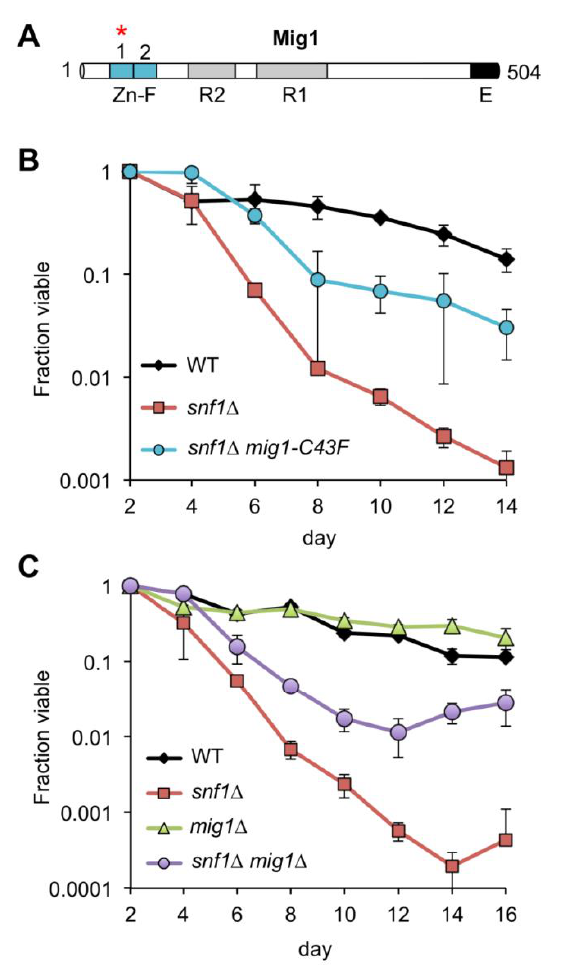
FIGURE 3: Mutations in MIG1 partially restore CLS to a snf1 ∆ strain. (A) Diagram of Mig1 protein domain organization showing the two zinc fingers (Zn-F), two regulatory domains (R1 and R2) and an effector domain (E) [36]. Red asterisk indicates the zinc finger mutated (C43F) in suppressor candidate JS1430. (B) Quanti- tative CLS assay showing short CLS of snf1 ∆ (JS1394) compared to WT (JS1256). The snf1 ∆ mig1-C43F mutant (JS1430) extends CLS compared to snf1 ∆. (C) Quantitative CLS assay showing similar partial CLS extension by deleting MIG1 in the snf1 ∆ background (JS1446). Deletion of MIG1 had little CLS effect on its own (JS1442). CLS assays were performed in SC 2% glucose conditions. Error bars indicate standard